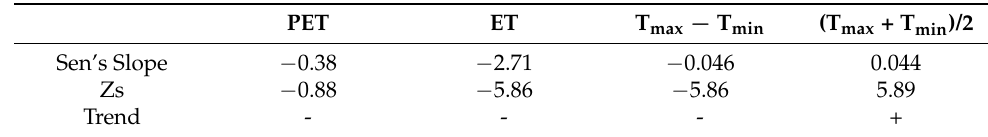
Figure 11. Implication of changes in hydrological cycles of the Bilate watershed. The symbol ↑ represents increasing trends while ↓ represents decreasing trends. Table 3. M-K trend test of annual PET, ET, (T max – T min ), and (T max + T min )/2.